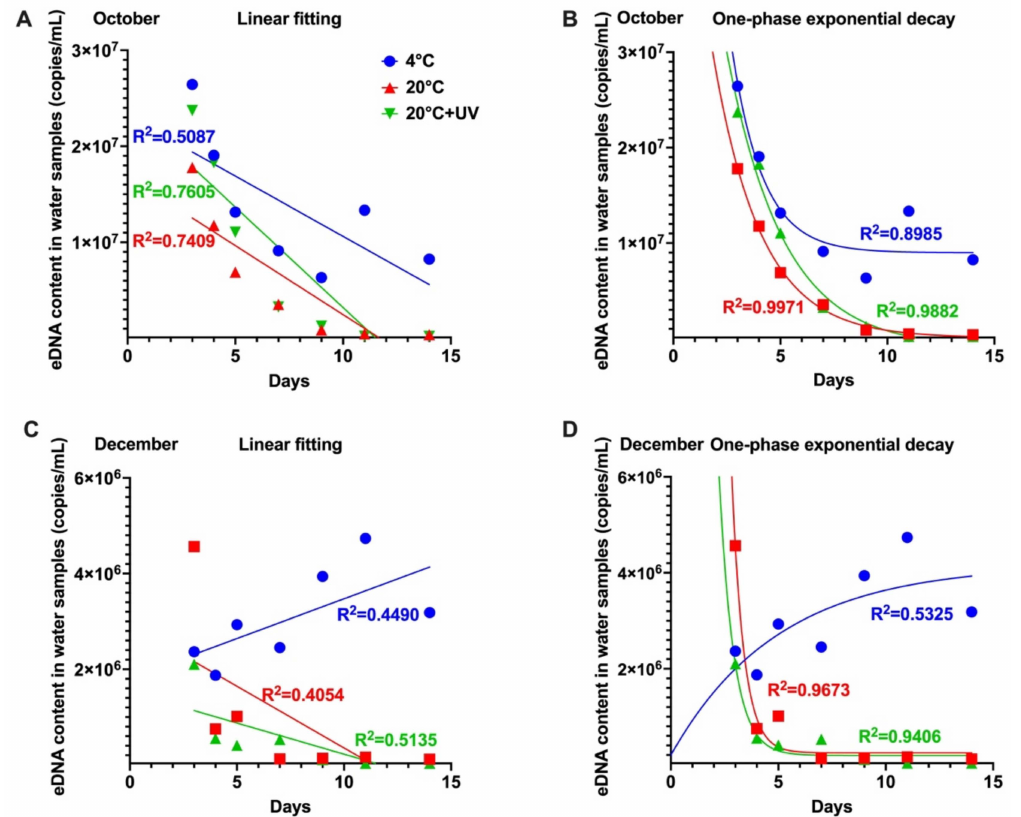
Figure 4. Relationship between residual eDNA content in the environment and decay time (from 3 days to 14 days) for 18S rRNA gene of eukaryotic DNA. ( A , B ) showed the linear fitting and one- phase exponential decay models in October samples, respectively. ( C , D ) showed the linear fitting and one-phase exponential decay models in December samples,